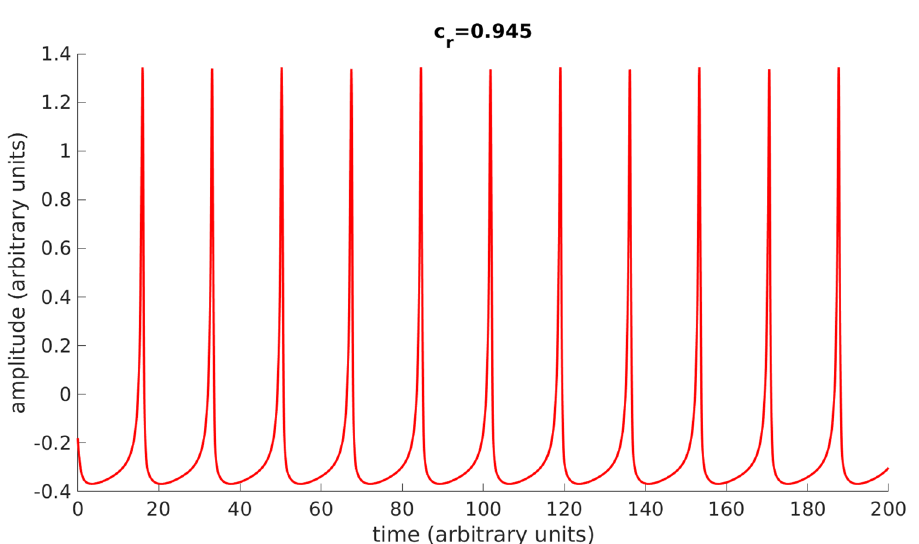
Figure 10. The amplitude and phase of a single mode for c r = 0.945